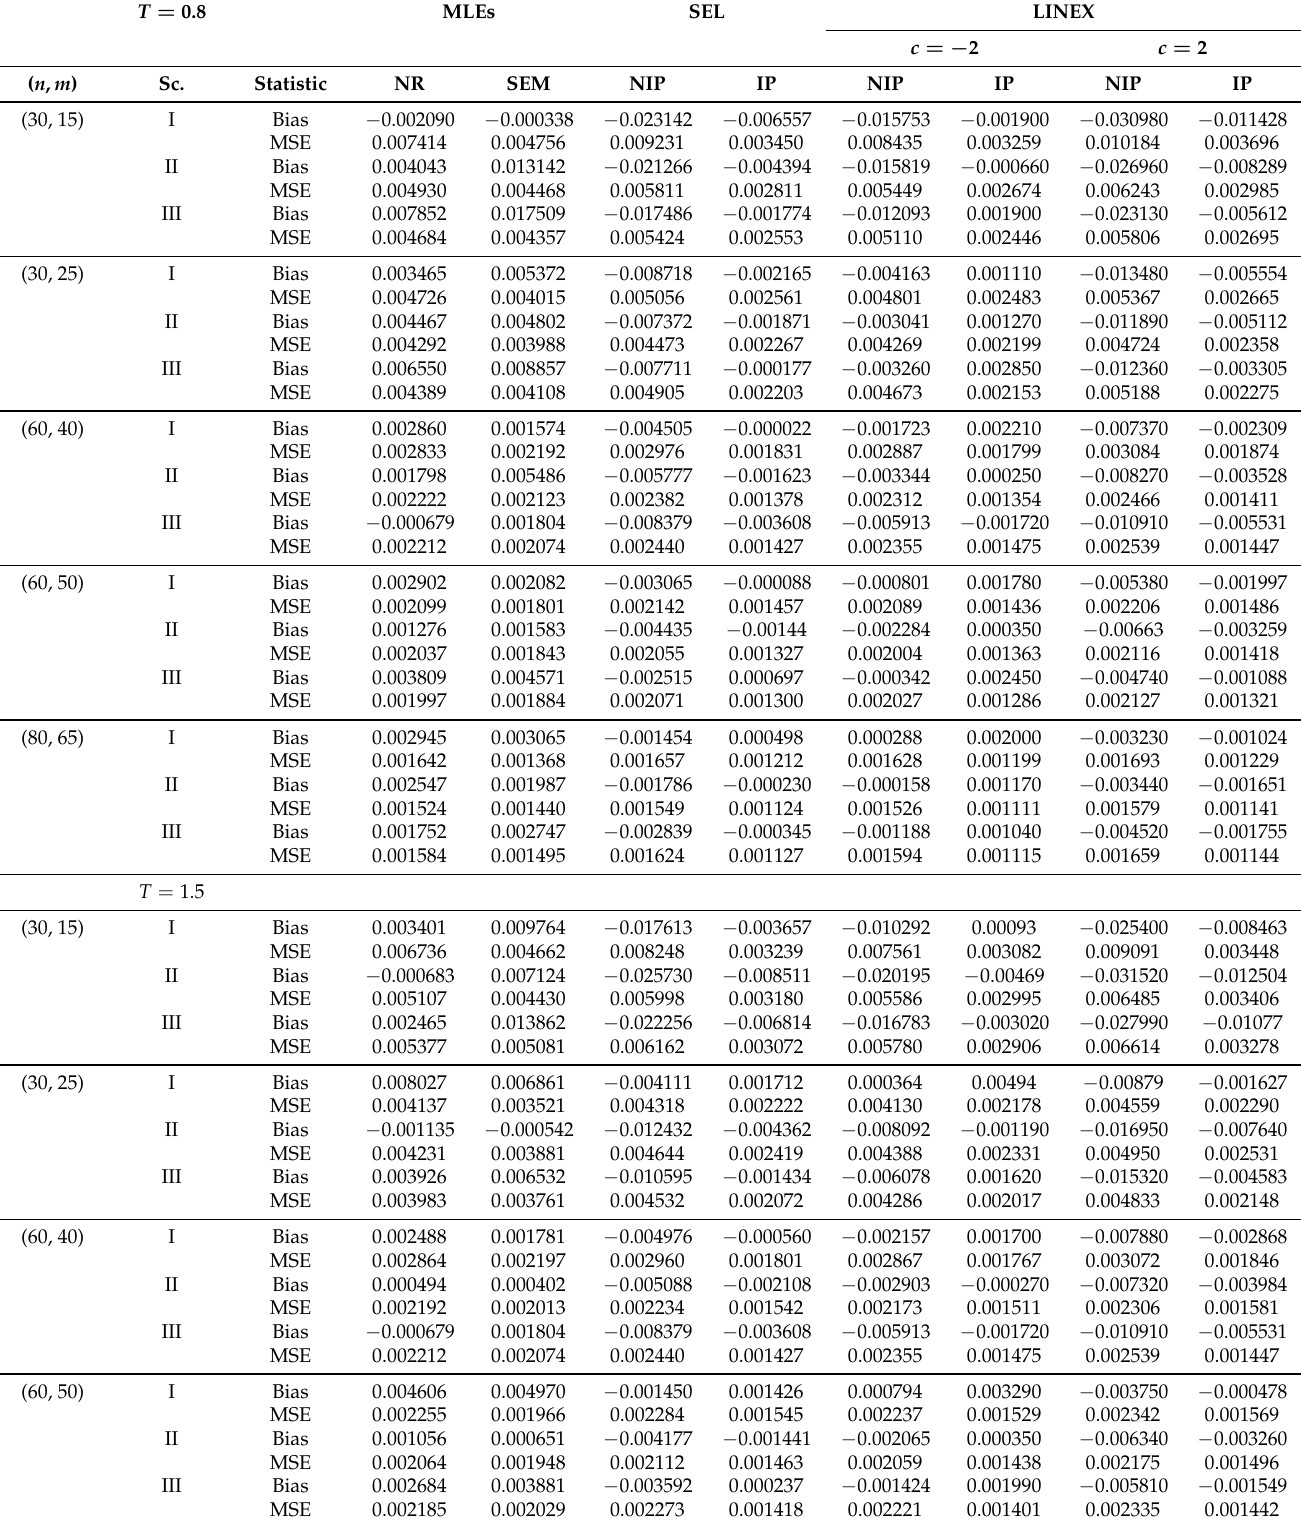
Table 11. Average values of the biases (first row) and MSEs (second row) for MLEs and Bayes estimators of S (t = 0.9) under informative prior (IP) and noninformative (NIP) prior and different censoring schemes, when ( θ 1 , θ 2 , λ ) = (0.05, 0.06,